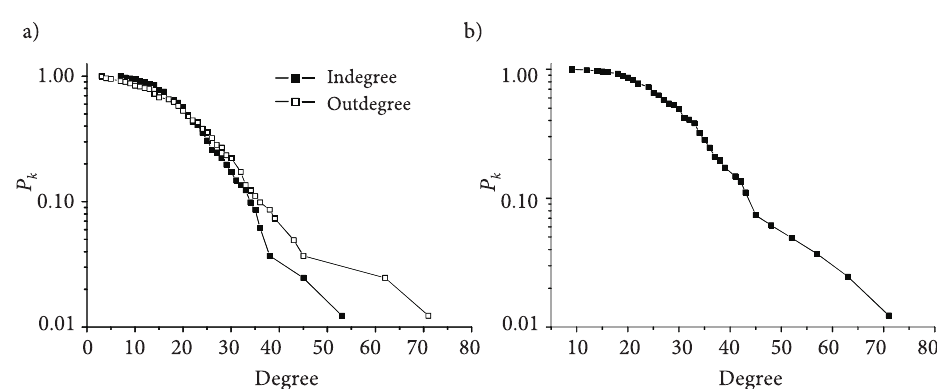
Fig. 2. Degree distribution (a) and direct network; (b) of a symmetrical network in the discipline knowledge network in